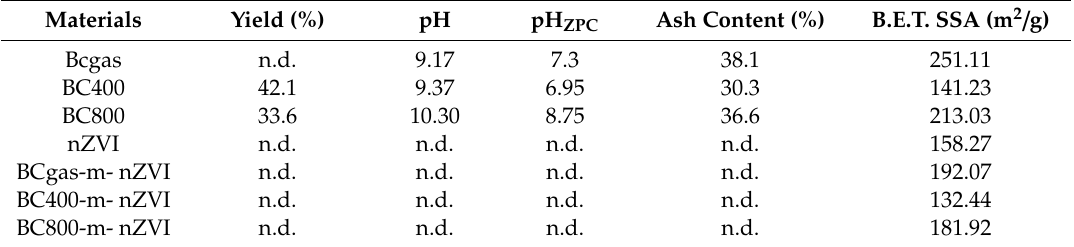
Table 2. Physico-chemical properties of the materials of full-scale gasification rice husk biochar